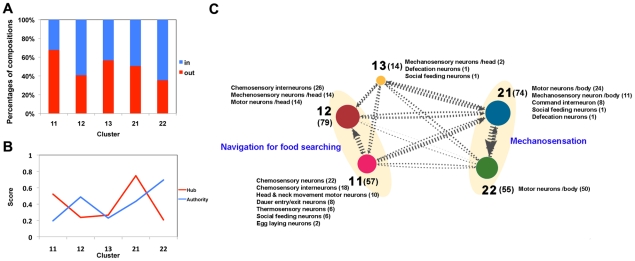
The structural relationship between 5 hierarchical clusters.(A) The ratio of in and out synapses for each cluster toward other clusters. (B) Hub and authority scores of each cluster. A cluster with a high hub score contains many outward synapses of high quality, whereas a cluster with a high authority score has high-quality inward synapses. (C) Representation of the hierarchical relationship between the clusters with their biological functions. The thickness of each edge and arrow is proportional to the synaptic weight between each dyad. The size of the circle representing a cluster is proportional to the intra-cluster synaptic weight of the cluster. The numbers in parentheses indicate numbers of neurons.